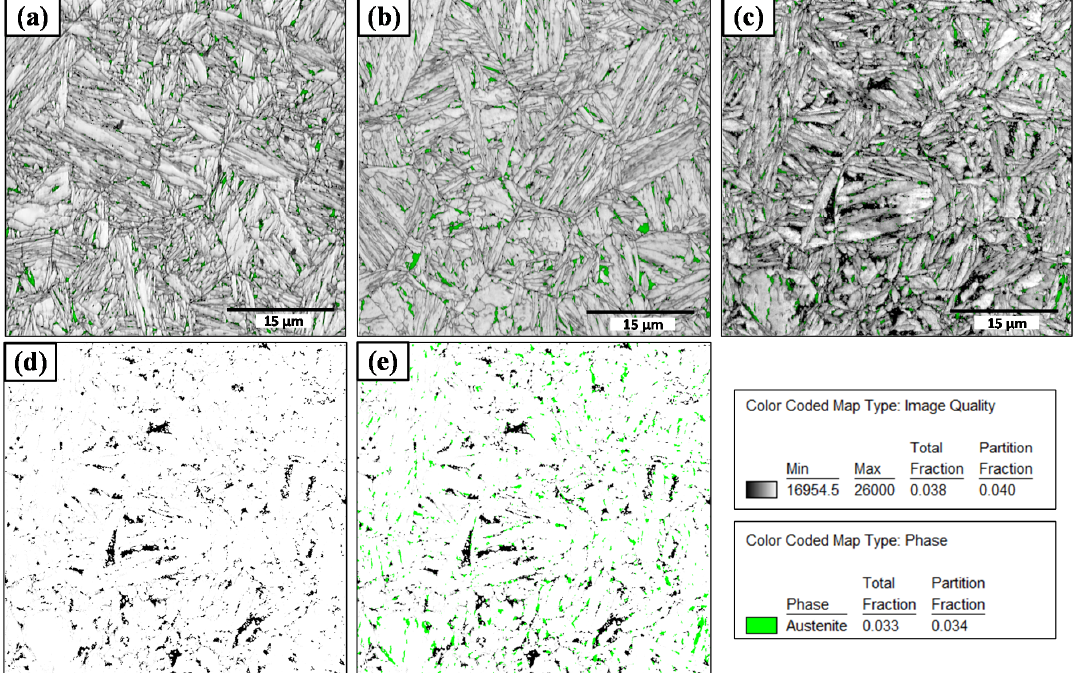
Figure 9. Electron backscatter diffraction (EBSD) maps of heat-treated grades; ( a ) image quality (IQ) and phase map of B360-HT, green color representing austenite phase, ( b ) IQ and phase map of B1400-HT, ( c ) IQ and phase map of CrB-HT, ( d ) IQ map of CrB-HT showing the M phase distribution (black), ( e ) IQ map and phase map of CrB-HT showing the M and austenite phase distribution.